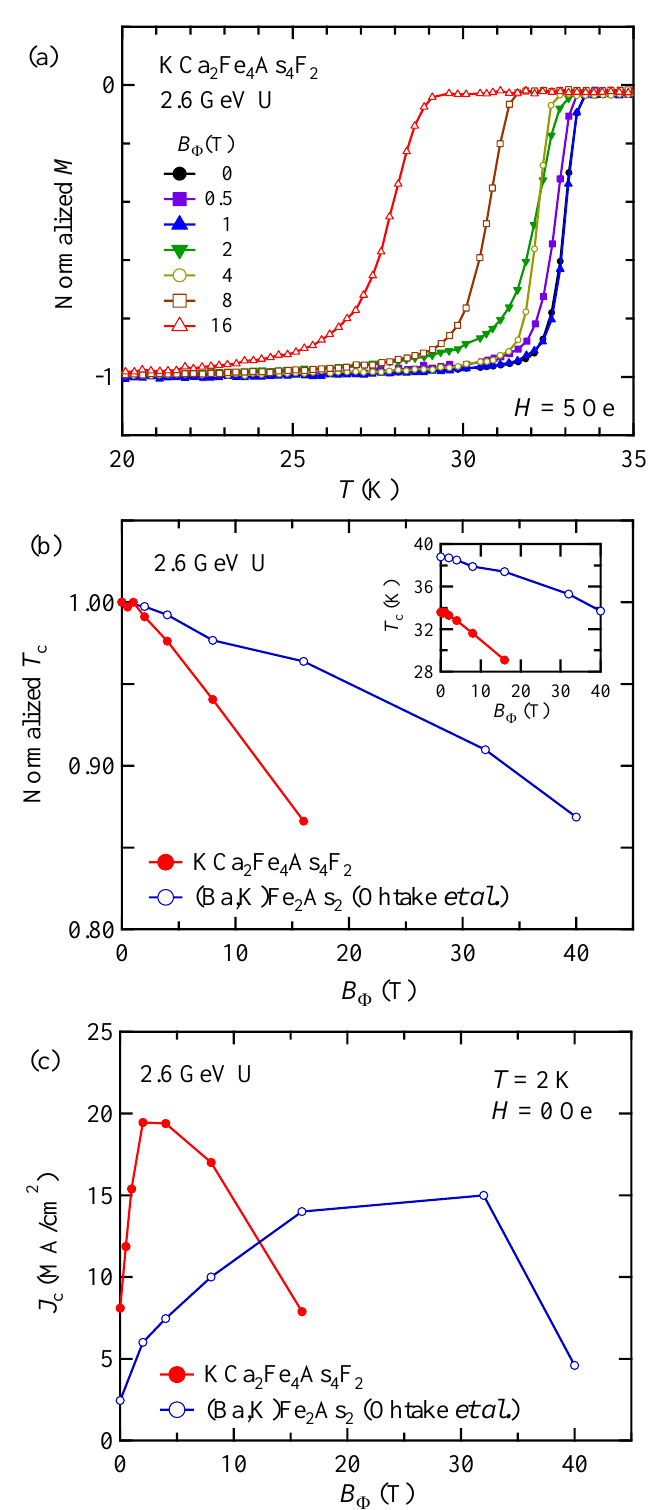
Figure 2. ( a ) Temperature dependence of normalized magnetization of 2.6 GeV U-irradiated KCa 2 Fe 4 As 4 F 2 with various B Φ at 5 Oe. The irradiation dose is evaluated by B Φ . The B Φ dependence of ( b ) normalized T c and ( c ) J c at 2 K under self-field in 2.6 GeV U-irradiated KCa 2 Fe 4 As 4 F 2 and (Ba,K)Fe 2 As 2 [26]. The B Φ dependence of T c is also shown in the inset of ( b ).